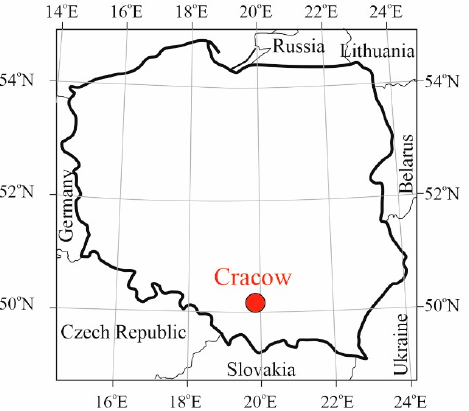
Figure 1. Location of the study area: Poland, Cracow (Source: own elaboration).